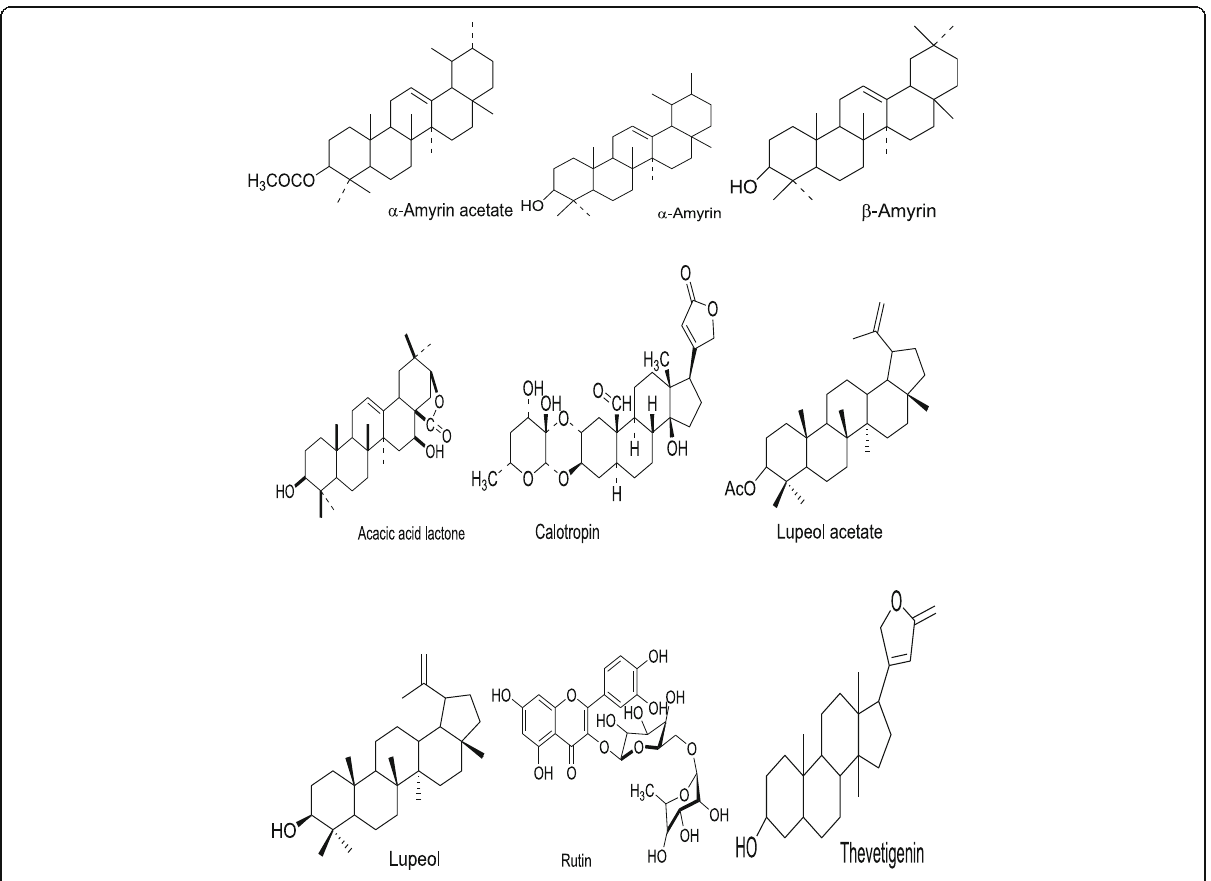
Fig. 3 Isolated compounds from plants having antifertility